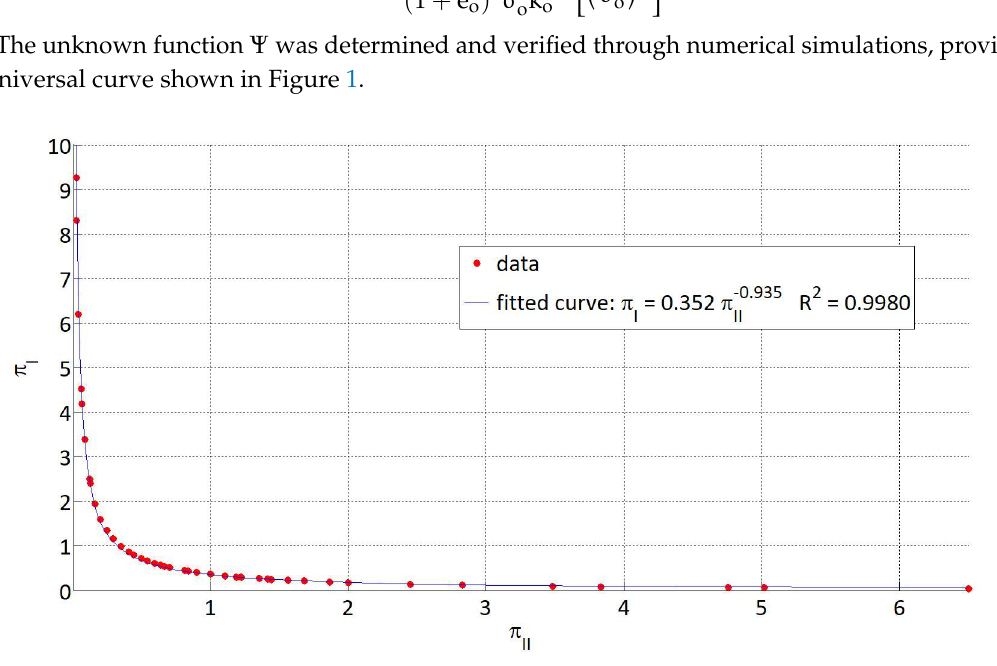
Figure 1. Universal curve π I = Ψ ( π II ). Alhama et al.